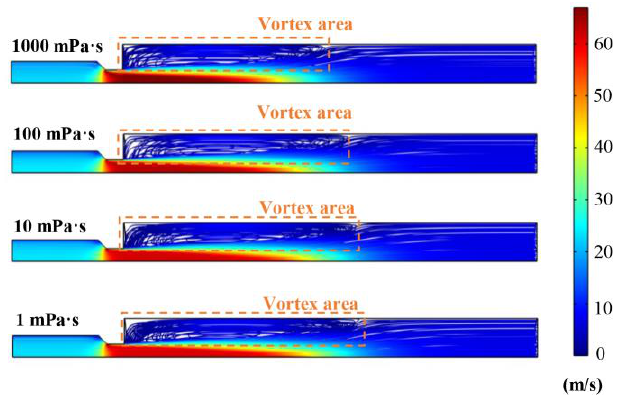
Figure 4. Velocity streamlines in the differential motion assembly with different fluid viscosities; the flow rate was 0.04 m 3 /s.